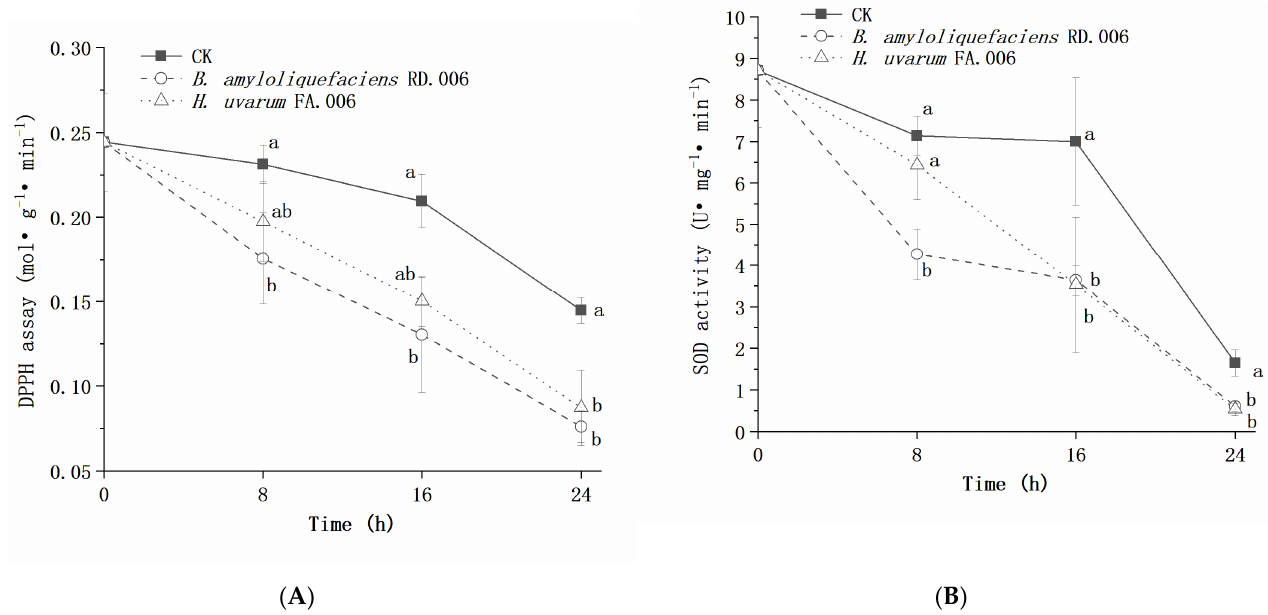
Figure 7. Effect of a biocontrol agent on DPPH scavenging capacity ( A ) and SOD activity ( B ) of Bot. dothidea JNHT01. Error bars represent standard deviations from the mean. a–b: different letters at the same time indicate significantly differences with a p < 0.05.